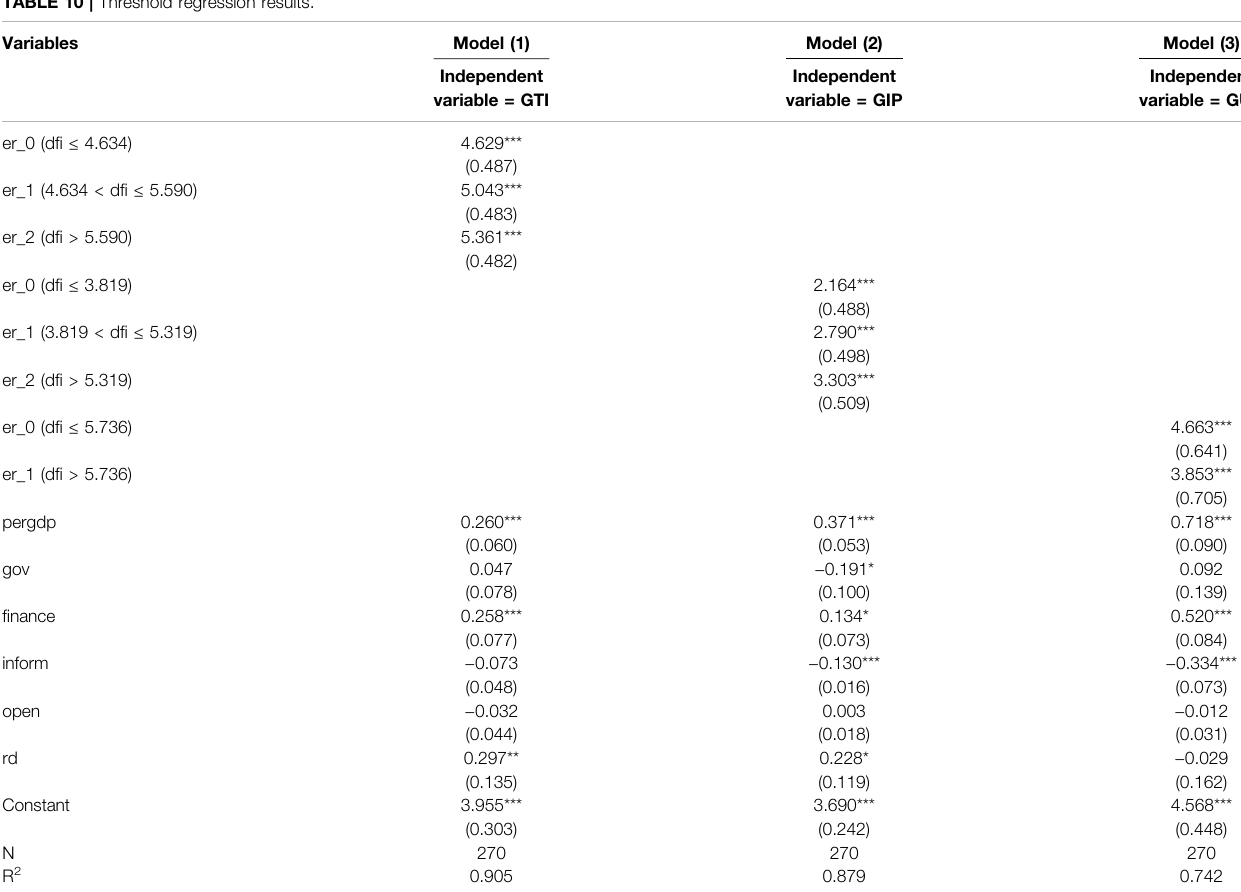
TABLE 10 | Threshold regression